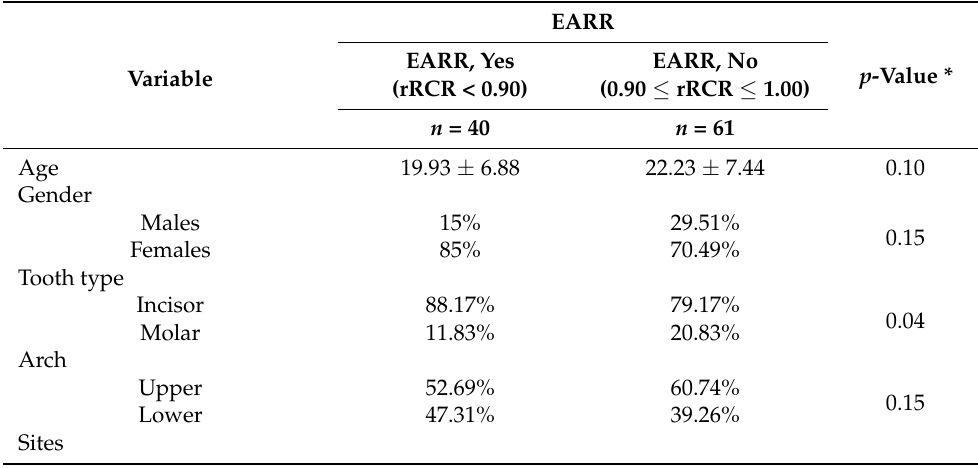
Table 2. Patient- and tooth-level variables and genetic polymorphisms according to EARR